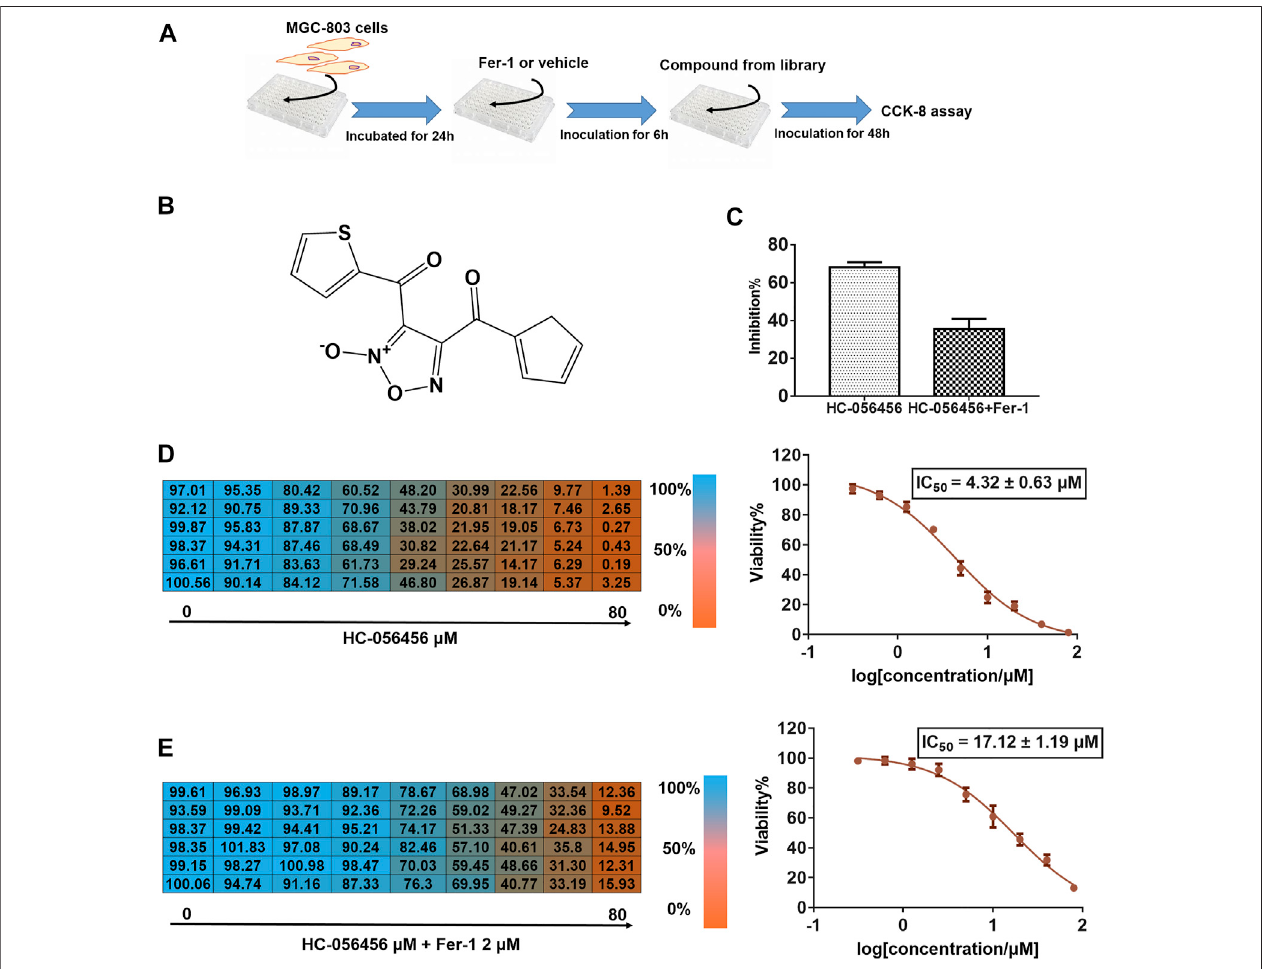
FIGURE 1 | HC-056456 exerted anti-proliferation effects on MGC-803, which can be restored by Fer-1 (A) Schematic illustration of the procedure of screening promiseferroptosisinducerfromBioactiveCompoundLibrary (B) StructureofHC-056456 (C) TheinhibitoryrateofHC-056456(5 μ M)onMGC-803withorwithoutFer- 1 (D) The inhibitory effect of HC-056456 on MGC-803. CCK-8 was used to determine the viability of cells (E) MGC-803 were exposed to various doses of HC-056456 and Fer-1 (2 μ M). Then, CCK-8 was used to determine the viability of